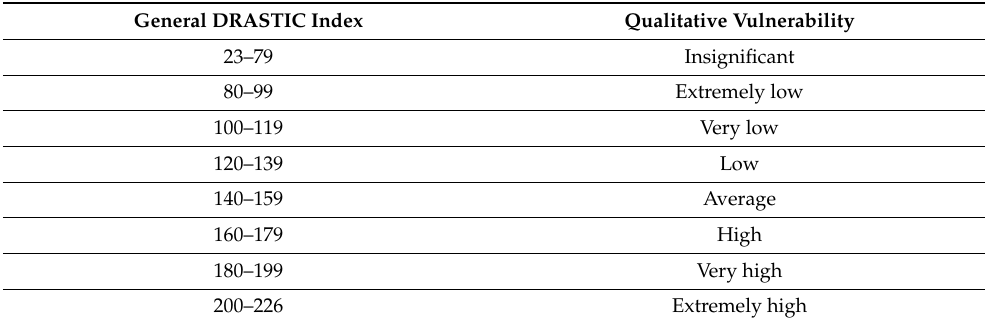
Table 1. Index value and DRASTIC vulnerability classes (adapted from [40,77]).